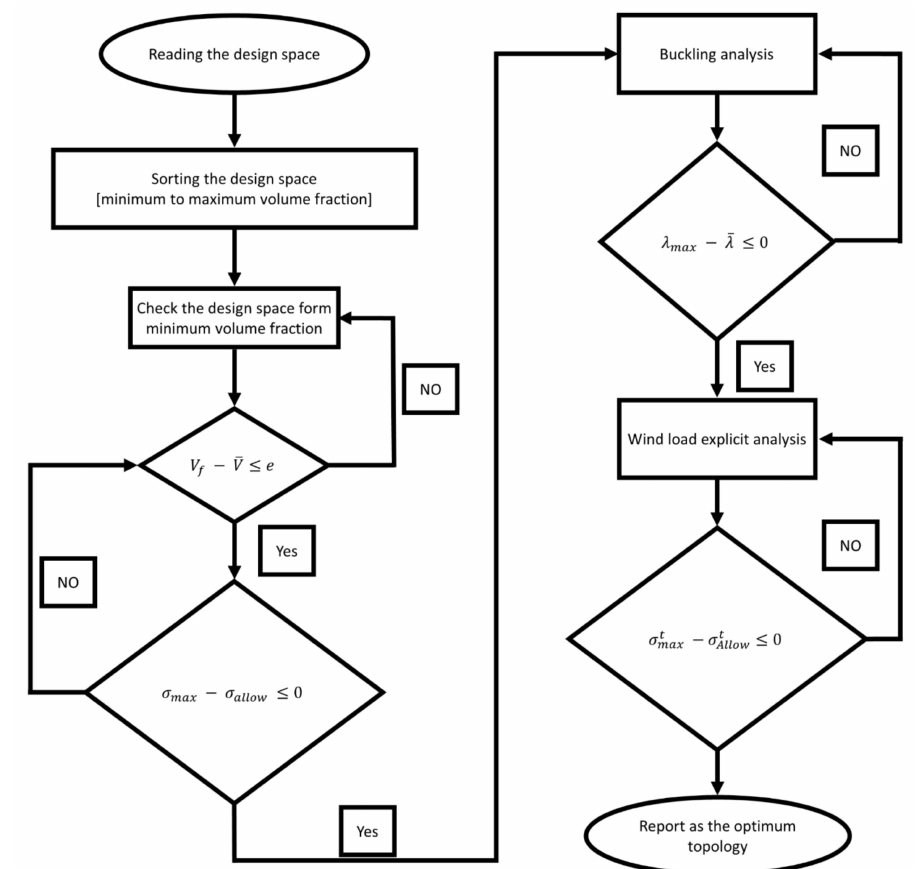
Figure 11. The workflow of selecting the lightest structure in the dataset with the minimum compliance.